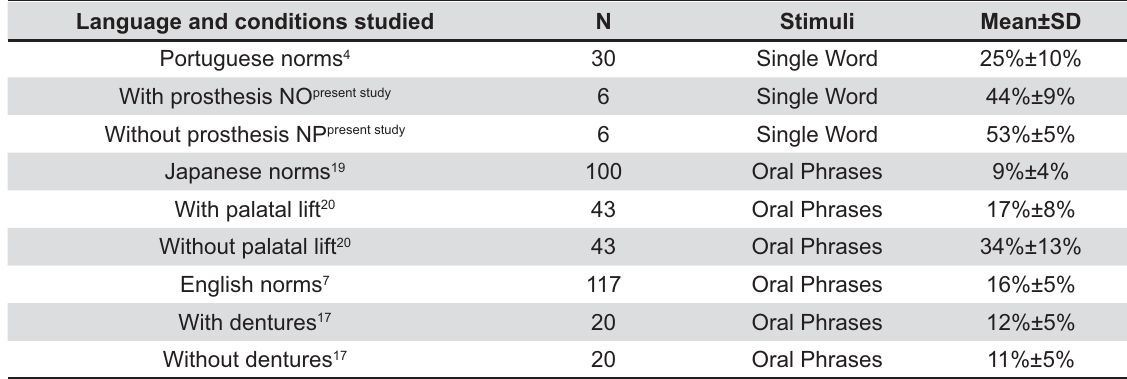
Table 2- (cid:2)(cid:3)(cid:4)(cid:5)(cid:5)(cid:6)(cid:7)(cid:8)(cid:2)(cid:9)(cid:10)(cid:2)(cid:11)(cid:12)(cid:13)(cid:14)(cid:12)(cid:15)(cid:16)(cid:2)(cid:9)(cid:10)(cid:2)(cid:17)(cid:7)(cid:18)(cid:16)(cid:18)(cid:12)(cid:19)(cid:2)(cid:6)(cid:12)(cid:13)(cid:2)(cid:17)(cid:7)(cid:18)(cid:20)(cid:14)(cid:9)(cid:4)(cid:16)(cid:2)(cid:16)(cid:19)(cid:4)(cid:13)(cid:14)(cid:18)(cid:16)(cid:2)(cid:10)(cid:9)(cid:7)(cid:2)(cid:19)(cid:21)(cid:18)(cid:2)(cid:22)(cid:9)(cid:12)(cid:13)(cid:14)(cid:19)(cid:14)(cid:9)(cid:12)(cid:16)(cid:2)(cid:23)(cid:14)(cid:19)(cid:21)(cid:2)(cid:6)(cid:12)(cid:13)(cid:2)(cid:23)(cid:14)(cid:19)(cid:21)(cid:9)(cid:4)(cid:19)(cid:2)(cid:17)(cid:7)(cid:9)(cid:16)(cid:19)(cid:21)(cid:18)(cid:16)(cid:14)(cid:16)(cid:24)(cid:2)(cid:14)(cid:12)(cid:22)(cid:25)(cid:4)(cid:13)(cid:14)(cid:12)(cid:15)(cid:2) number of samples, speech stimuli, nasalance scores (mean, Standard Deviation)